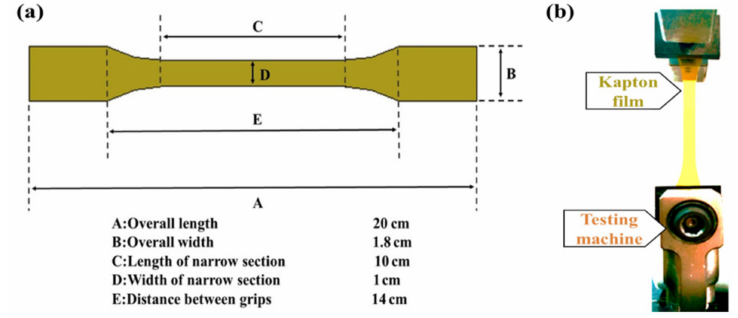
Figure 1. ( a ) Dimensional drawings of dumbbell-shaped specimen; ( b ) digital photo of uniaxial tensile